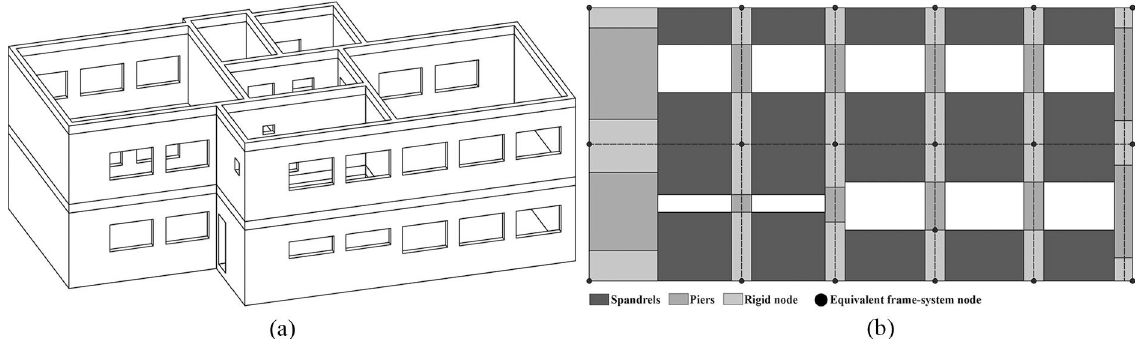
Fig 3. Modelling of the 3D building (a) and macroelements of the south wall (b) (Authors’ ownership).